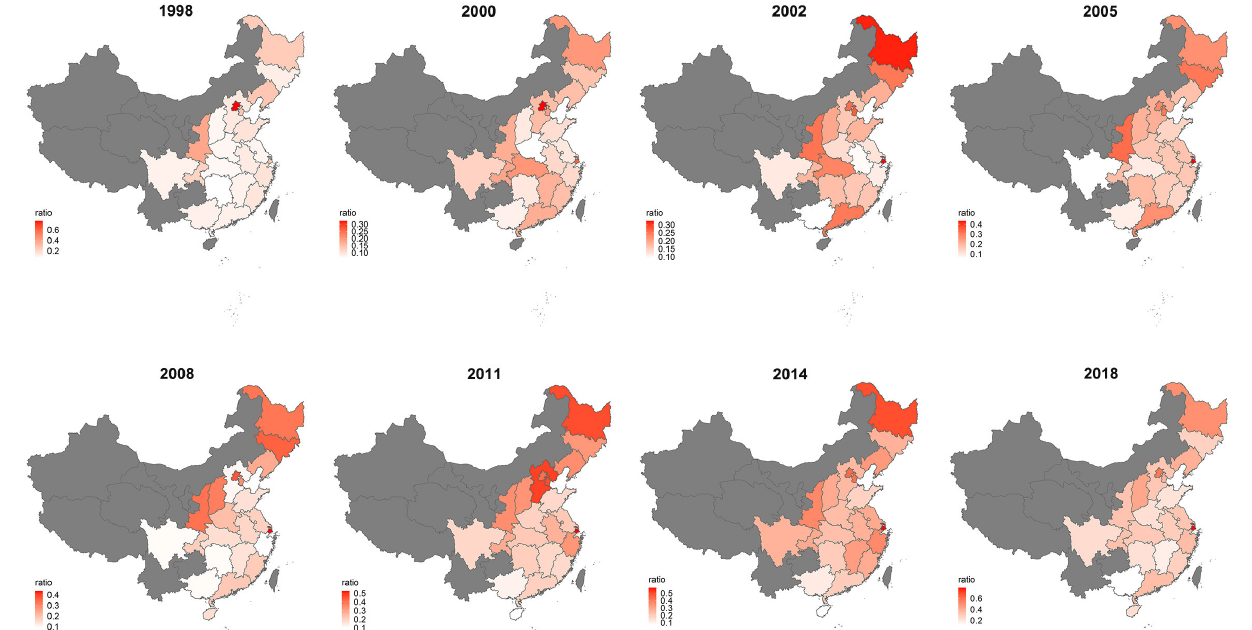
Frontiers in Medicine |